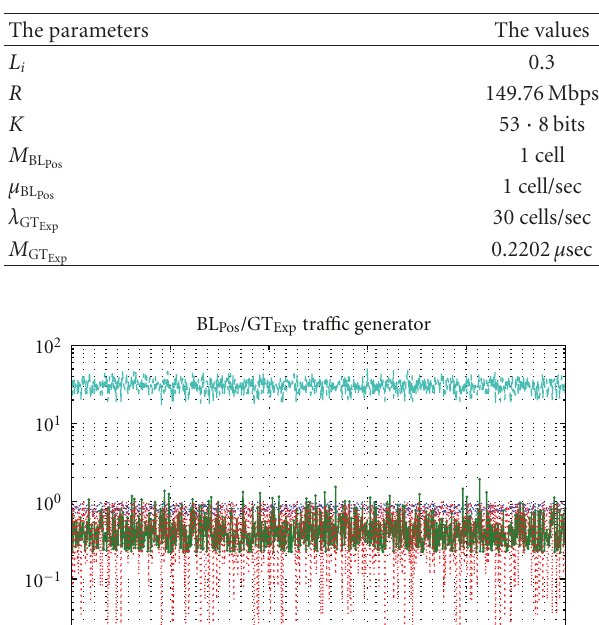
Table 1: The evaluated parameters for the BL Pos / GT Exp tra ffi c generator.